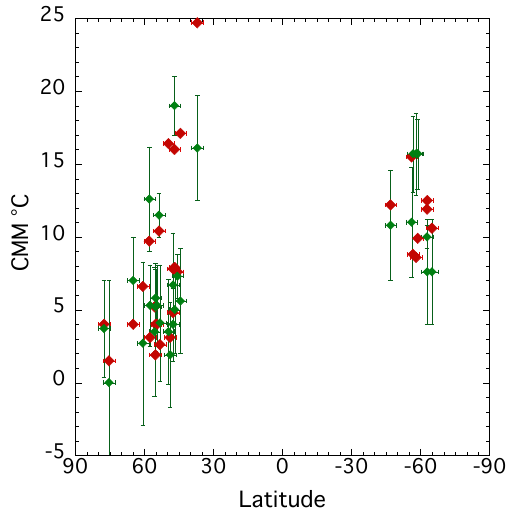
Fig. 6. A pointwise comparison of cold month mean tempera- ture (CMM) from the EOCENE-4480 (red) and proxy data esti- mates(green) versus latitude. The error bars are as described in the text.